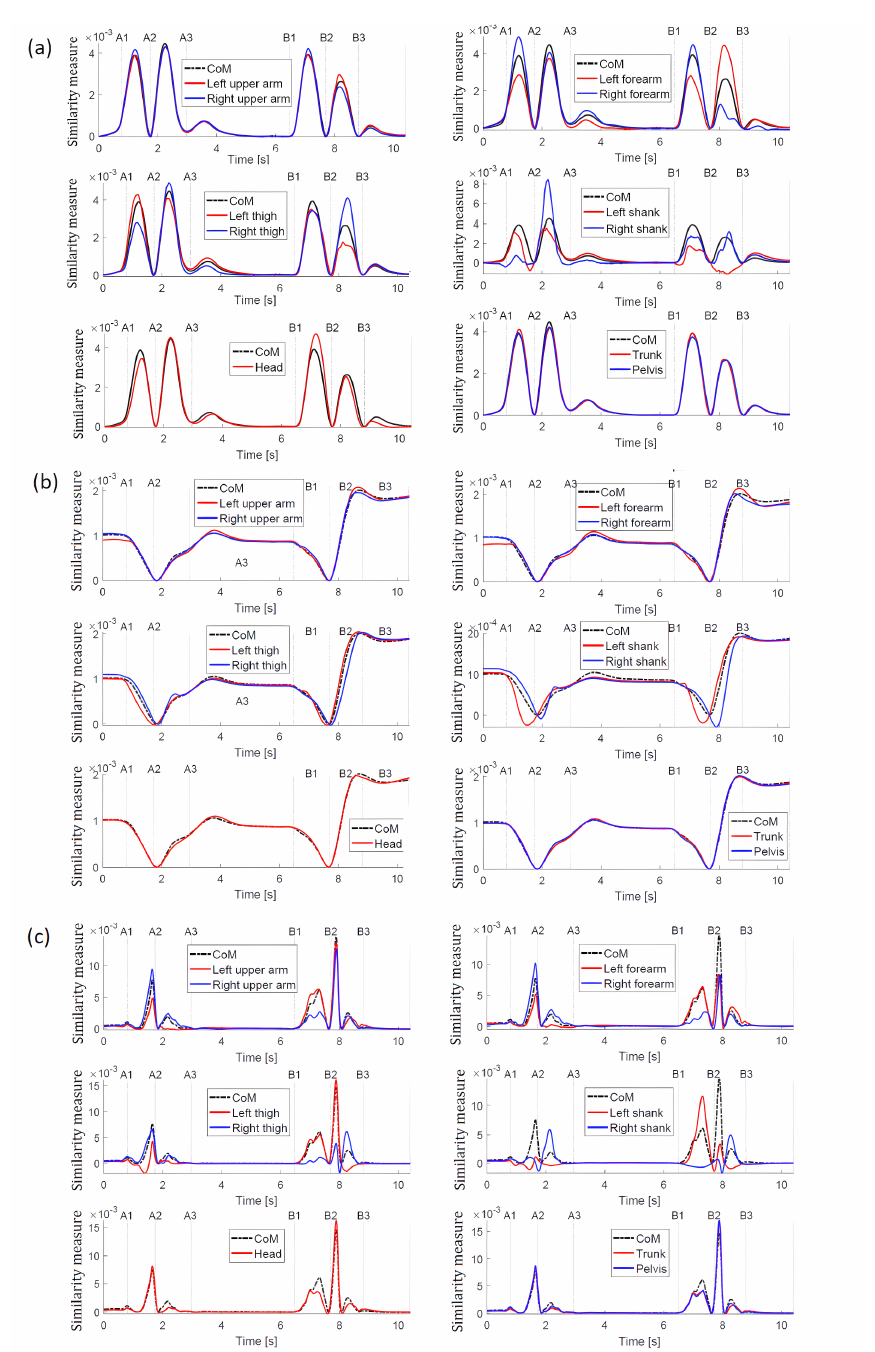
Figure 5. Trajectories of the similarity measure during the stepping. ( a ) trajectories along the X-axis; ( b ) trajectories along the Y-axis; ( c ) trajectories along the Z-axis. Comparing Figure 6a containing the trajectories of displacements of point masses of the body with Figure 5a, one can see that, in the latter figure, the differences and similarities of displacements are much more